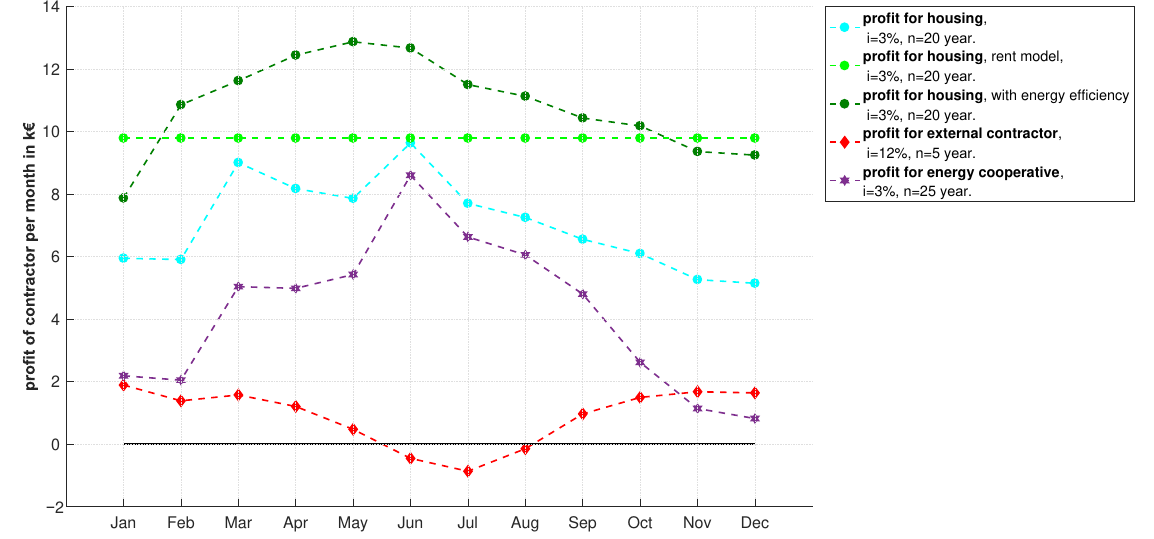
Figure 8. Comparison of monthly profits of contractor for examined business cases.